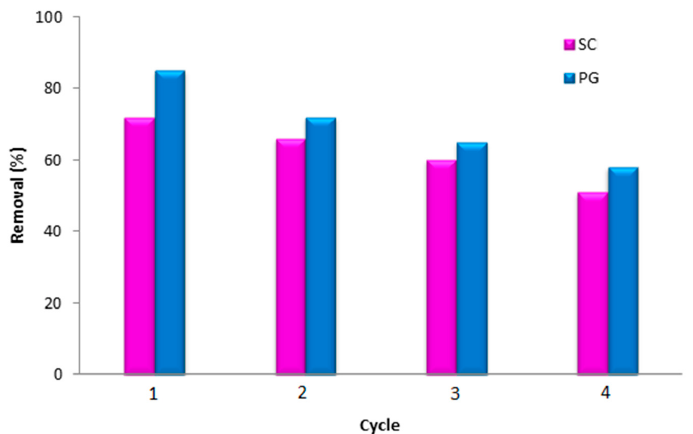
Figure 10. Variations in fluoride removal efficiency of both biosorbents after four consecutive adsorption/desorption cycles.